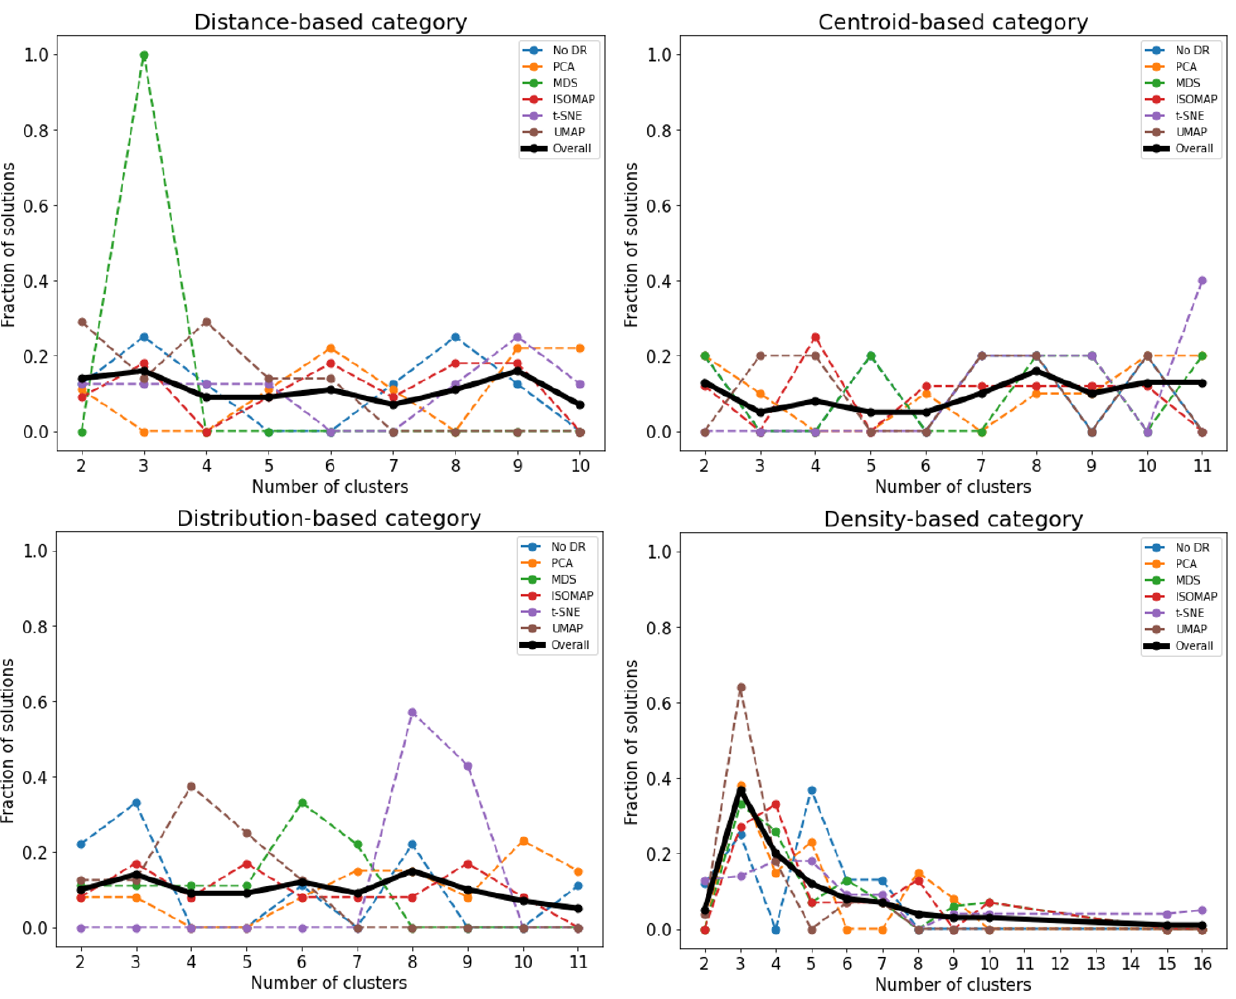
Figure 8. Fraction of solutions representing found number of clusters in the TEP data set for each DR